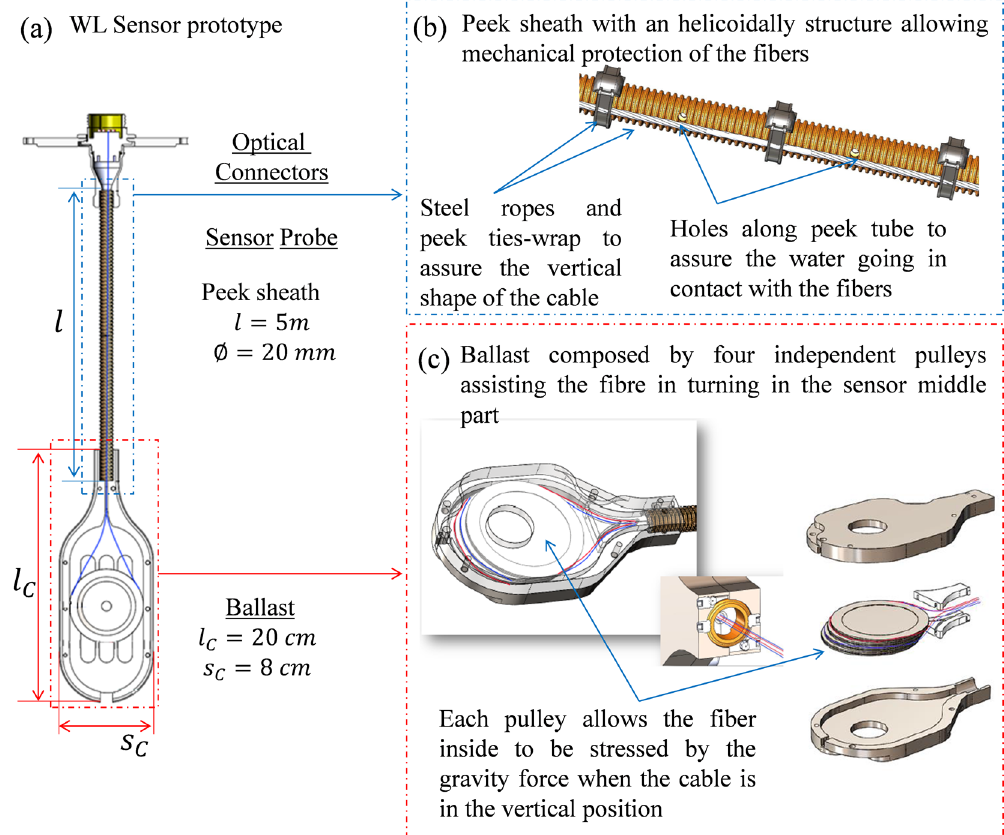
Figure 4. WL sensor prototype technical layout, ( a ) where the three principal parts are highlighted, i.e. the optical connector subassembly, the sensor probe cable and the ballast. The fibre path is represented by the blue line inside the cable. ( b , c ) Characteristics of the central cable and the